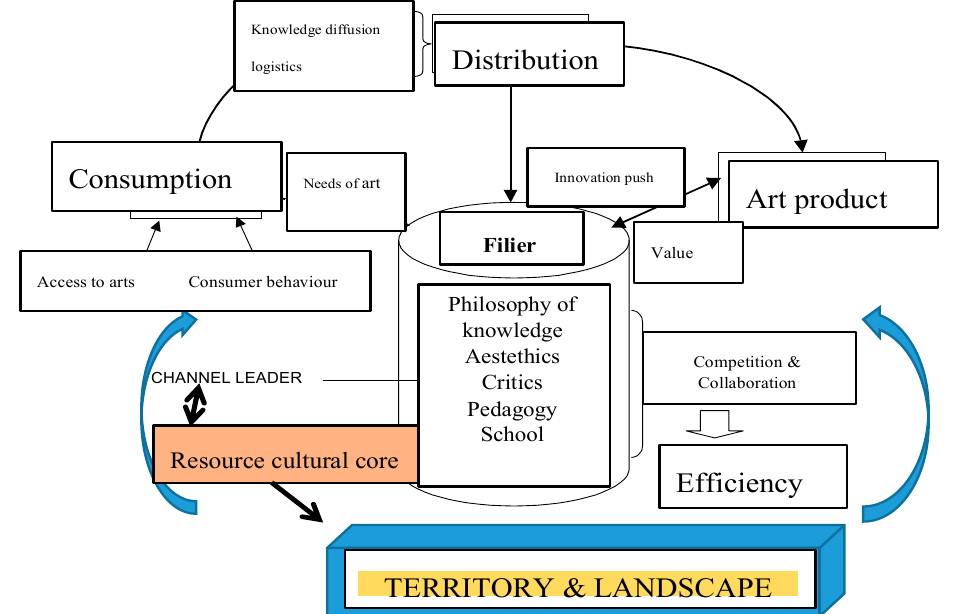
Figure 1. Artistic and cultural resources’ supply chain structure, access, and transition channels [4].